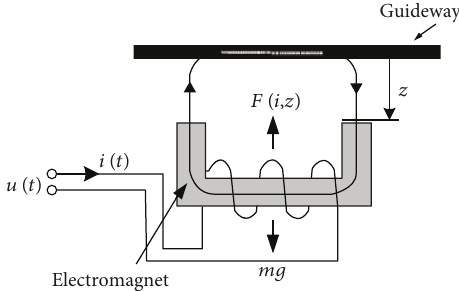
Figure 7: Model of the electromagnetic levitation